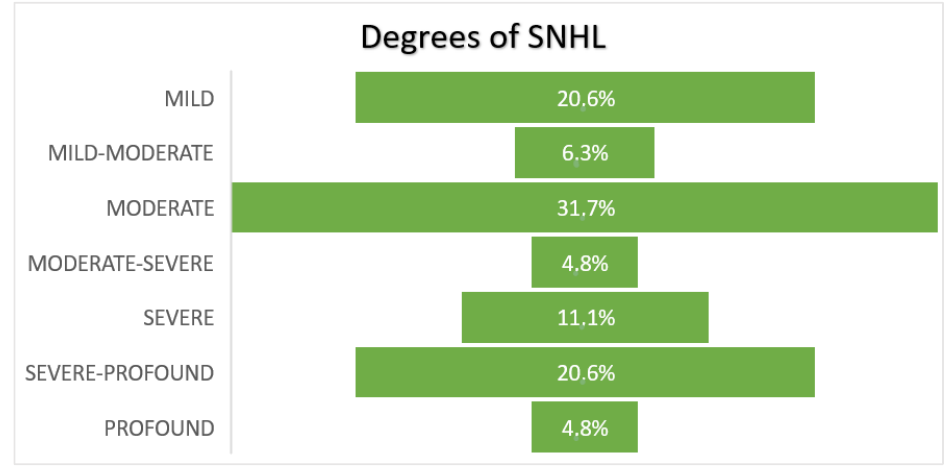
Figure 2. Severity of hearing loss in the patients included in the study. In 12.7% of the patients, SNHL was described as an isolated symptom; whilst, in 87.3%, it was associated with other symptoms (see Figure 3). Interestingly, in three cases, facial palsy incidents were associated with SNHL.